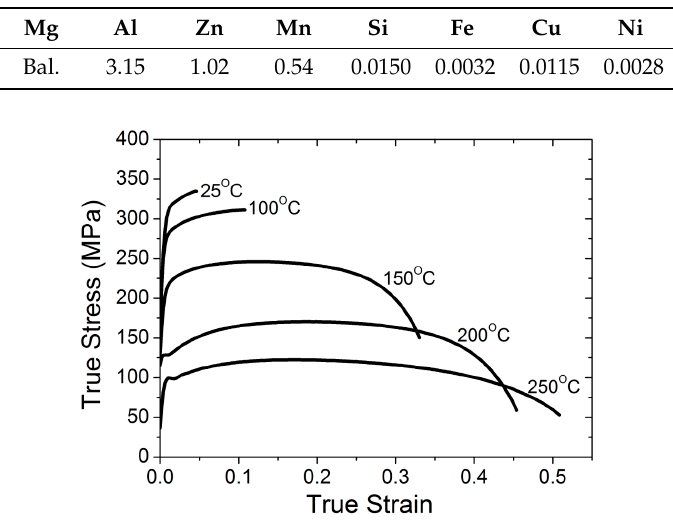
Figure 2. Stress–strain curves of the uniaxial tensile tests at various temperatures for the magnesium alloy (AZ31B), along 0° to the rolling direction and 0.16/s strain rate, obtained from the NUMISHEET 2011 benchmark study (BM 2) [25].